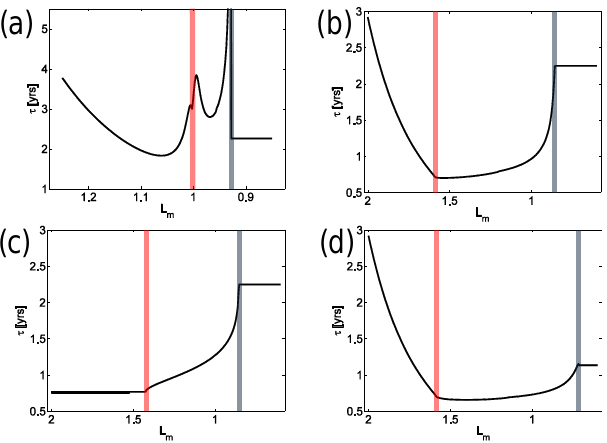
Figure 2. Relaxation timescale in Eisenman’s (2012) box model for different combinations of mechanisms. (a) Original model; (b) orig- inal model but with disabled ice–albedo feedback; (c) like (b) but without growth–thickness feedback; (d) like (b) but with only half the default ocean heat capacity. The vertical shaded lines indicate the values of L m where the annual minimum (red) and maximum (blue) ice volume reaches